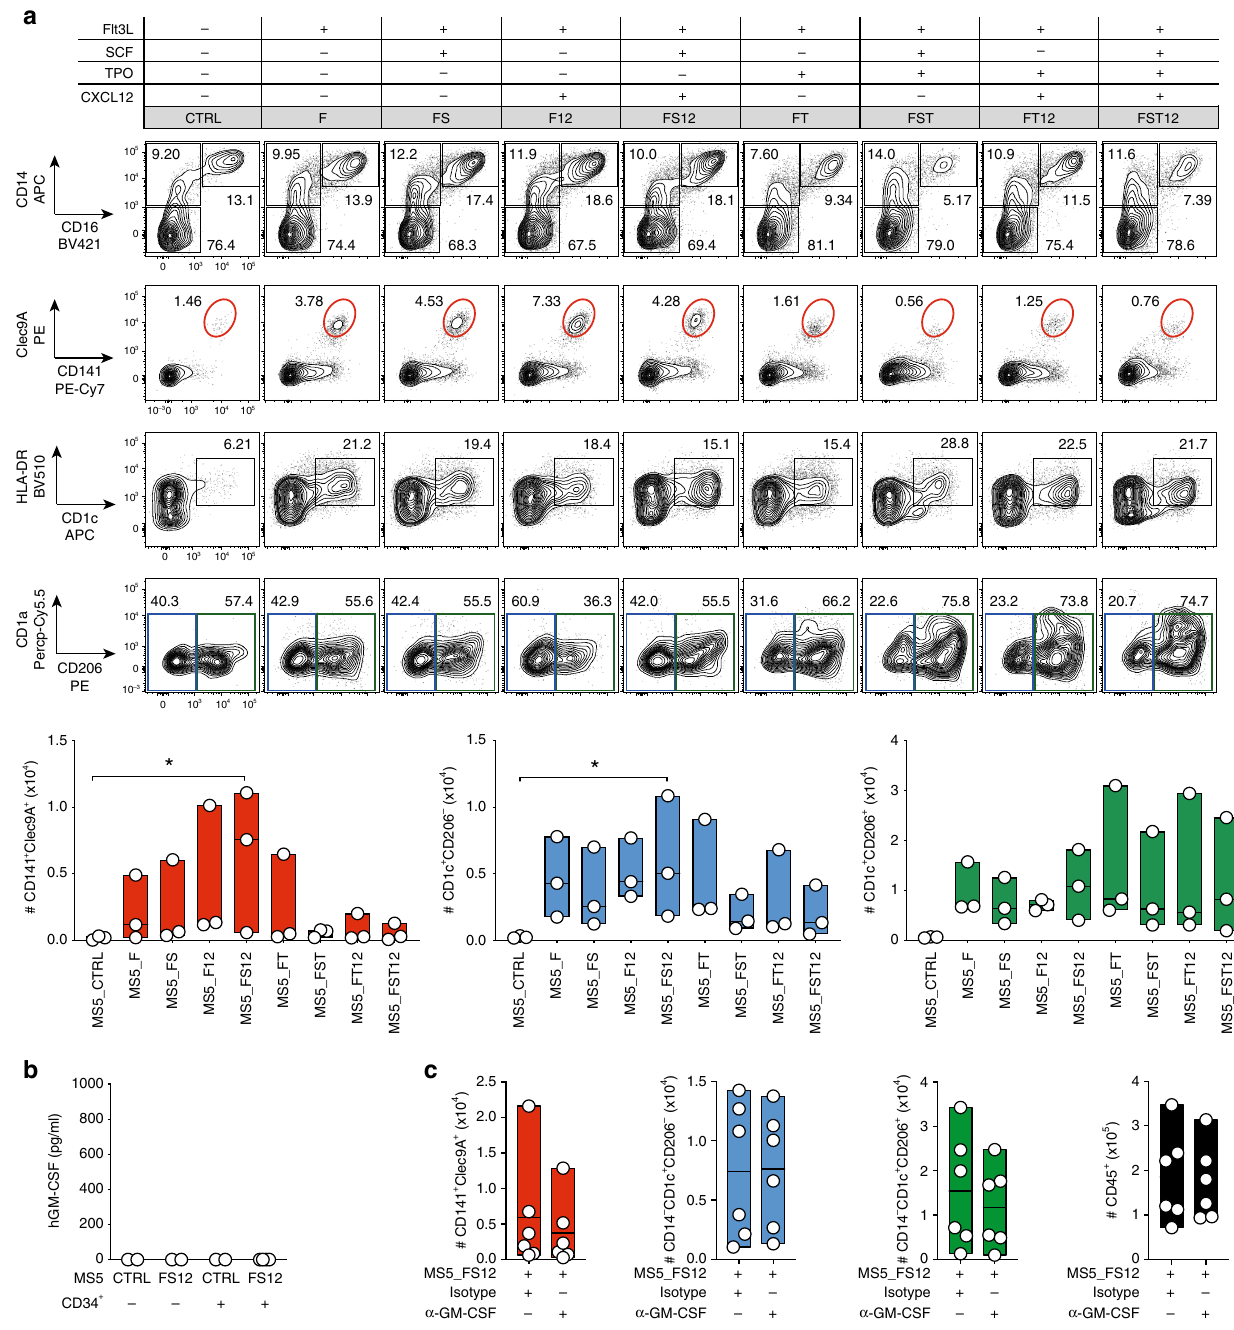
Fig. 2 CXCL12 and SCF improve FLT3L-driven DC differentiation. a Representative FACS plots and absolute number of CD141 + Clec9A + , CD1c + CD206 − , and CD1c + CD206 + cells generated from CD34 + HSPCs cultured with MS5 expressing human FLT3L (MS5_F) in combination with human SCF (S), TPO (T), and CXCL12 (12). Day 15 fl ow cytometry analysis of n = 3 cord blood donors in three independent experiments. * p < 0.05, one-way ANOVA test with Tukey ’ s multiple comparisons. b ELISA detecting human GM-CSF in the supernatant of CD34 + HSPCs cultured with engineered MS5 expressing human FLT3L, SCF and CXCL12 (MS5_FS12) at day 15 for n = 2 (MS5_CTRL ± CD34 + HSPC and MS5_FS12 only) and n = 4 (MS5_FS12 + CD34 + HSPC) independent donors. c Absolute number of human DC subsets generated in vitro from CD34 + HSPC using MS5_FS12 stromal cells in the presence of human GM-CSF neutralizing antibody as compared to isotype control ( n = 6 independent donors in two experiments). Data are presented as fl oating bars ranging from min to max and line represents median a , c or as b a r graphs with mean ± SEM ( b